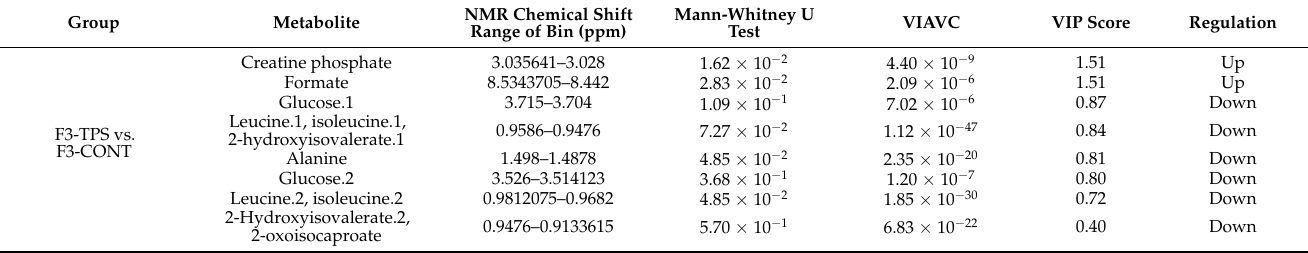
Table 1. p -values of blood plasma metabolites found to be significant in male Long-Evans rats in either a Mann–Whitney U test, the variable importance analysis based on random variable combination (VIAVC), or both. Rats were either non-stressed (CONT), transgenerationally-stressed (TPS), or multigenerationally-stressed (MPS). Up- or downregulation of the metabolites is also indicated. Metabolites with multiple peaks are represented as metabolite.1, metabolite.2… metabolite.n.